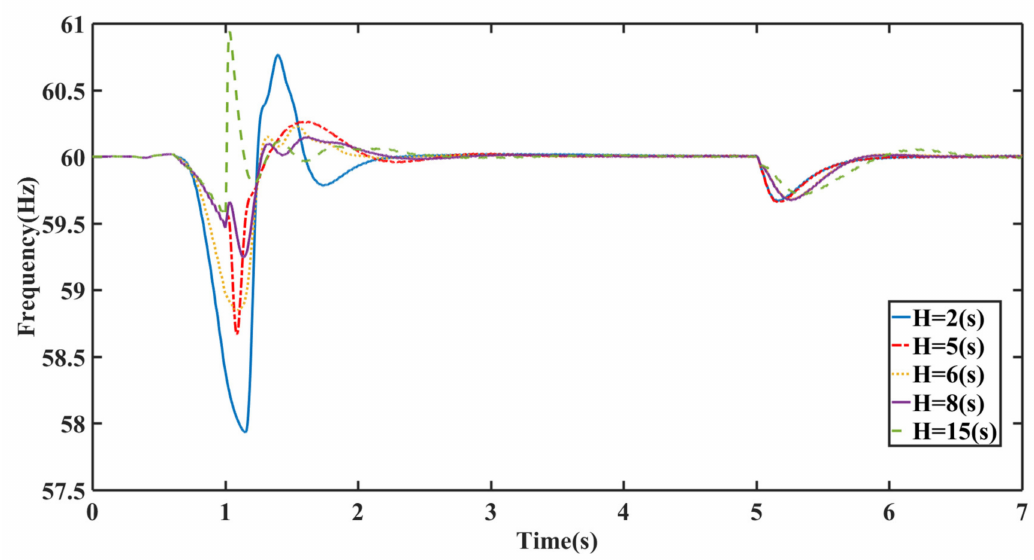
Figure 19. Frequency deviation during 100 MW SG outage in the presence of different values of inertia